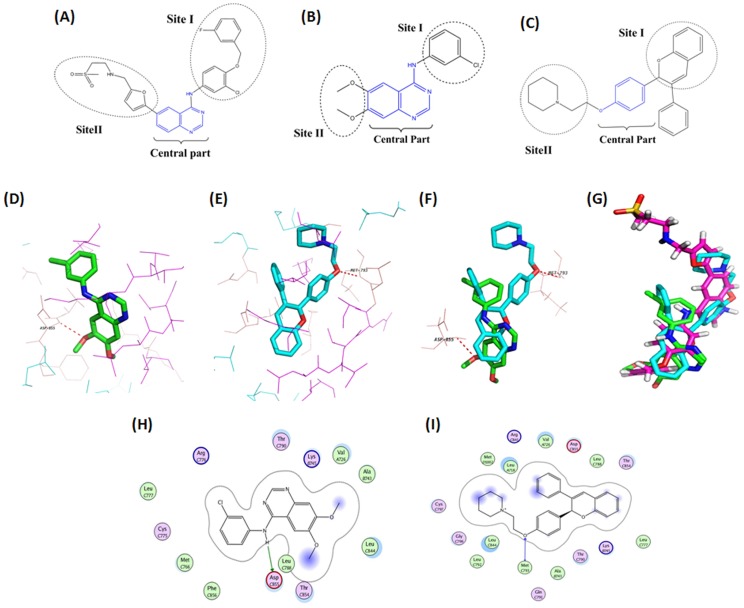
Molecular Docking analysis of CDRI-85/287 with EGFR.(A) Schematic partitioning of Lapatinib in the ATP-binding pocket. In the binding pocket quinazolin moiety of lapatinib has occupied the central place with benzyloxyphenyl and furan-methylamine moieties extending to its either side (wing I & II respectively). (B) Schematic partitioning of AG 1478 in the ATP-binding pocket. The chlorobenzene moiety of AG 1478 are designated as wing-I & dimethoxy moiety partially represent wing II site. The quinazoline moiety of AG 1478 has acted as central part of the scaffold. (C) Comparison of CDRI 85/287 structural moieties with AG 1478. (D) Docked conformation of AG 1478 with wild type EGFR protein (PDB ID. 1XKK). Red dash indicate H-bond interaction site with of EGFR where cyan, magenta & salmon colour specify alpha-helix, beta-sheet & loop regions of protein correspondingly. (E) Docked conformation of CDRI 85/287 analogue with EGFR protein (PDB ID 1XKK). Red dash shows H-bond interaction site with same protein site. (F) Superimposition of AG 1478 & CDRI 85/287 in a same protein binding pocket shows H-bond interaction with ASP855 & MET793 residues respectively. (G) Superimposition of Lapatinib (magenta), AG 1478 (green) and CDRI 85/287 derivative (Cyan). (H) Schematic 2D-representation of AG 1478. (I) proposed binding mode of CDRI 85/287 analogue with surrounding residues in the ATP-binding pocket of EGFR.